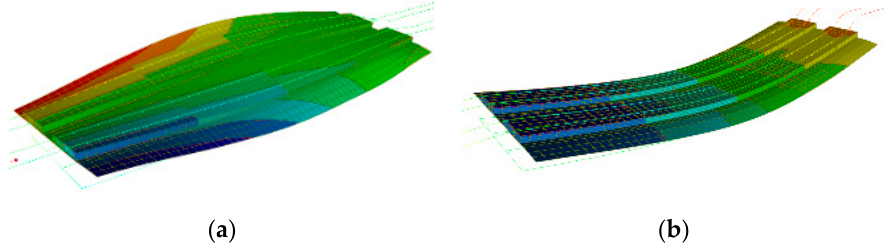
Figure 8. Vibration modes for span length of 30 m: ( a ) first mode (torsion); ( b ) second mode (flexure).